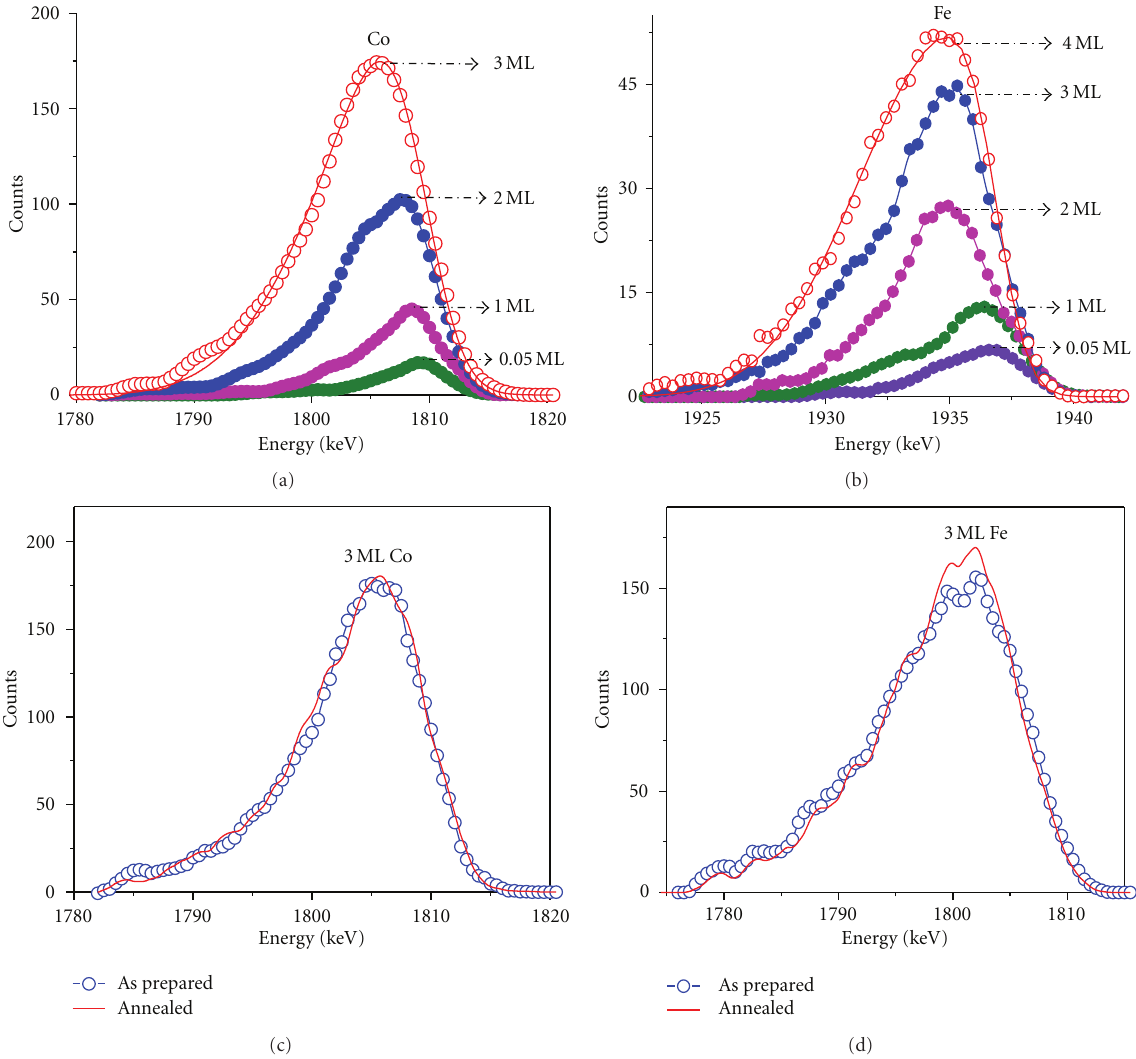
Figure 7: HRBS spectra of grown and thermal stability of ferromagnetic metal films (Co, Fe) on a MgO tunnel barrier/Si (100) structure. (a) Growth of Co (0.05–3 ML) using 2Mev N + ions for analysis at an incidence angle of 8 ◦ . RUMP simulation is also shown for 3 ML of Co. (b) Growth of Fe (0.05–4 ML) using 2Mev He + ions at an incidence angle of 3 ◦ . RUMP simulation is also shown for 4ML of Fe. (c) HRBS spectra of 3ML of Co as prepared (open circles) and after annealing at 450 ◦ C for 15 min (solid line). (d) HRBS spectra of 3 ML of Fe as prepared (open circles) and after annealing at 450 ◦ C for 15min (solid line). No major changes are